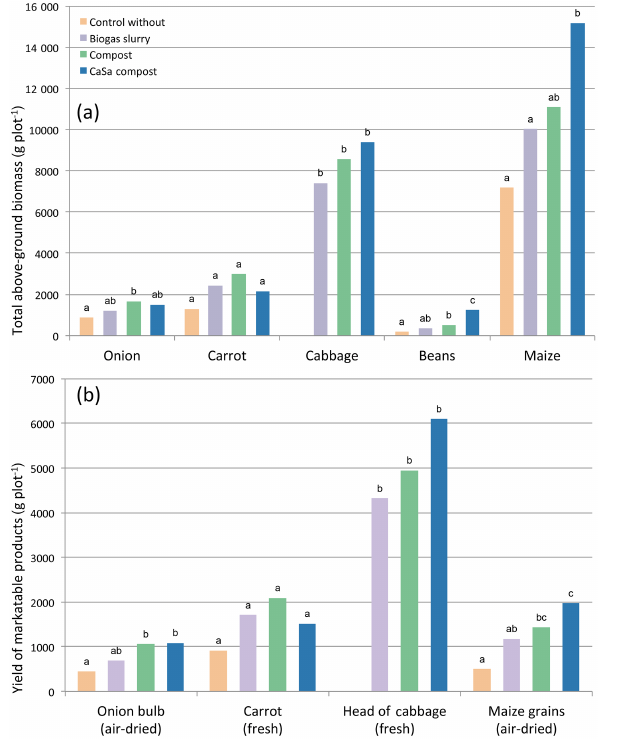
Figure 3. Total above-ground biomass production and marketable yields of food crops given as grammes per plot. Each plot comprised a 4.5m 2 area sown with maize and a 4.5m 2 area intercropped with onions, beans, cabbage, carrots, African eggplant and pepper. Dif- ferent letters reflect means differing significantly from one another (HSD, Tukey test, α = 0.05; n = 4 for the untreated control plots; n = 5 for the amended plots). Plot data are provided in Table